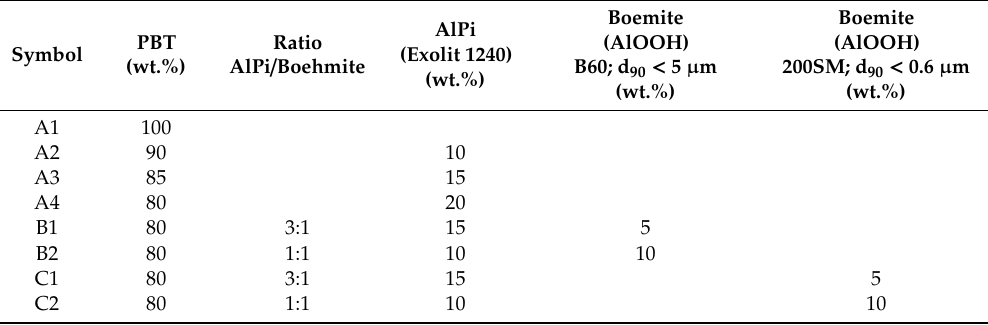
Table 1. Design of experiment—polymer / flame retardant